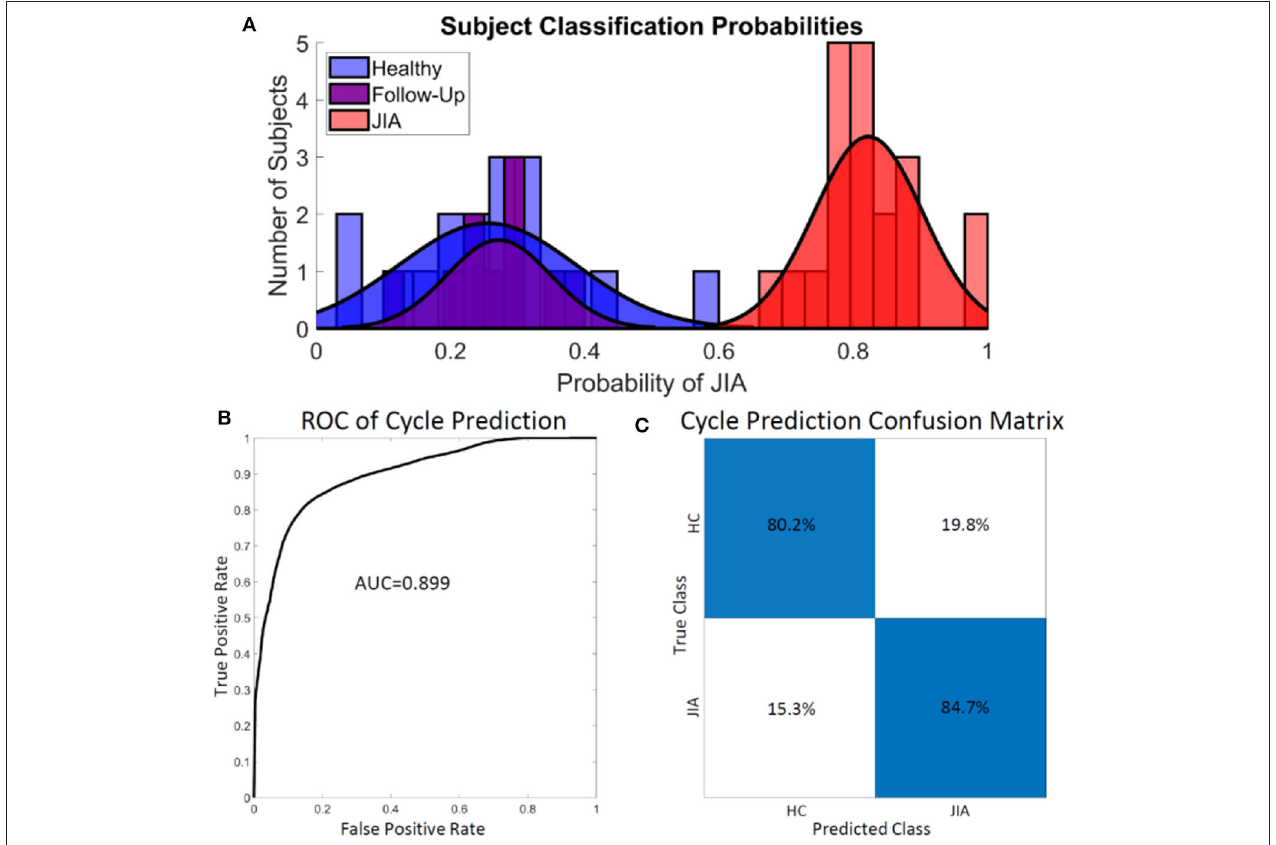
FIGURE 3 | Assessing the performance of the logistic regression classifier on subjects (A) and cycles (B,C) . (A) There was little overlap in the computed joint health score of the healthy control group and the group with JIA. A sub-group from the JIA group after effective treatment had JIA scores heavily overlapping with the healthy control group at follow-up. (B,C) The logistic regression model overall classified the individual cycles accurately 82.7% of the time. The model achieved adequately high sensitivity (84.5%) and specificity (80.4%). HC, healthy